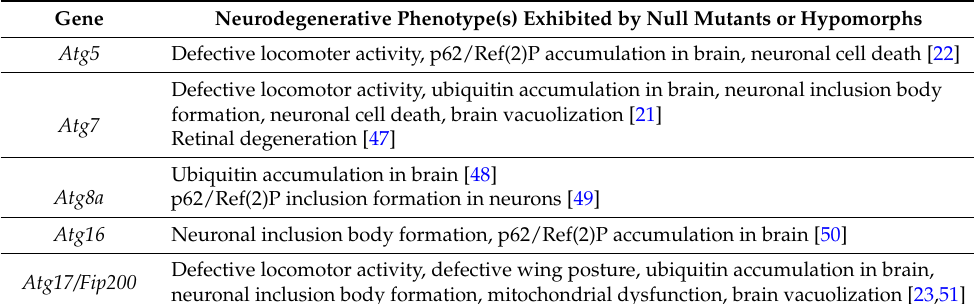
Table 1. Autophagy gene mutations in Drosophila that provokes neurodegenerative